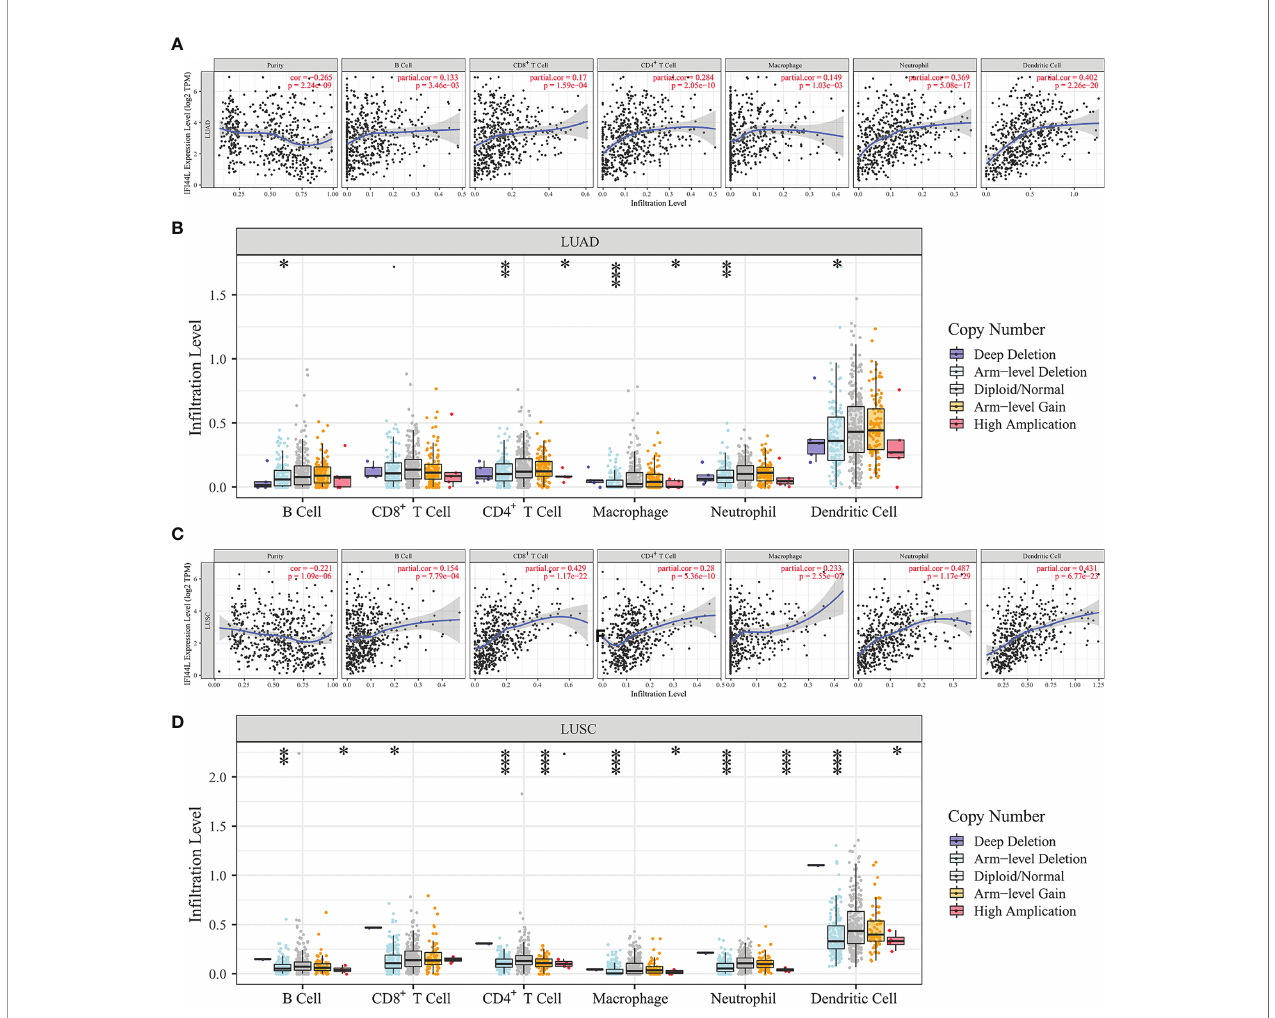
FIGURE 2 | Exploration of the immune association of IFI44L in LUAD and LUSC samples through TIMER database. (A, C) Relevance between IFI44L and six TIICs in LUAD samples (A) and LUSC samples (C) . (B, D) Comparison of in fi ltration levels among tumor samples with different CNV types of IFI44L in LUAD samples (B) and LUSC samples (D) . TIMER, Tumor IMmune Estimation Resource; CNV, copy number variation; TCGA, The Cancer Genome Atlas; LUAD, lung adenocarcinoma; LUSC, lung squamous cell carcinoma; TIICs, tumor-in fi ltrating immune cells; * p < 0.05, ** p < 0.01, *** p <